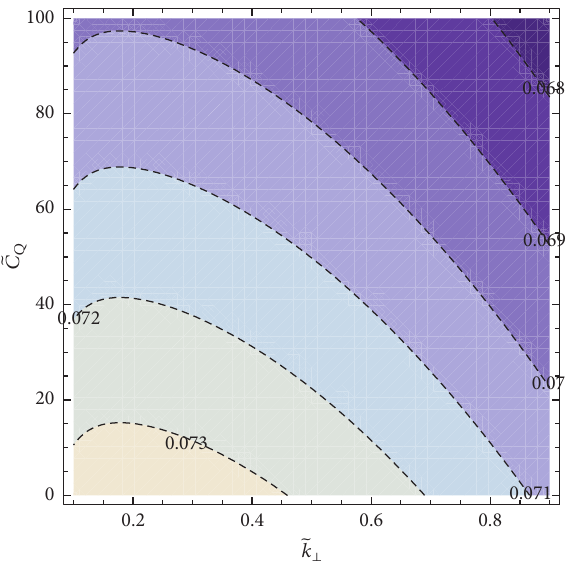
̃𝑘 𝐶 𝑉 = 10 , 𝑍 ⊥ and 𝑄 for 0